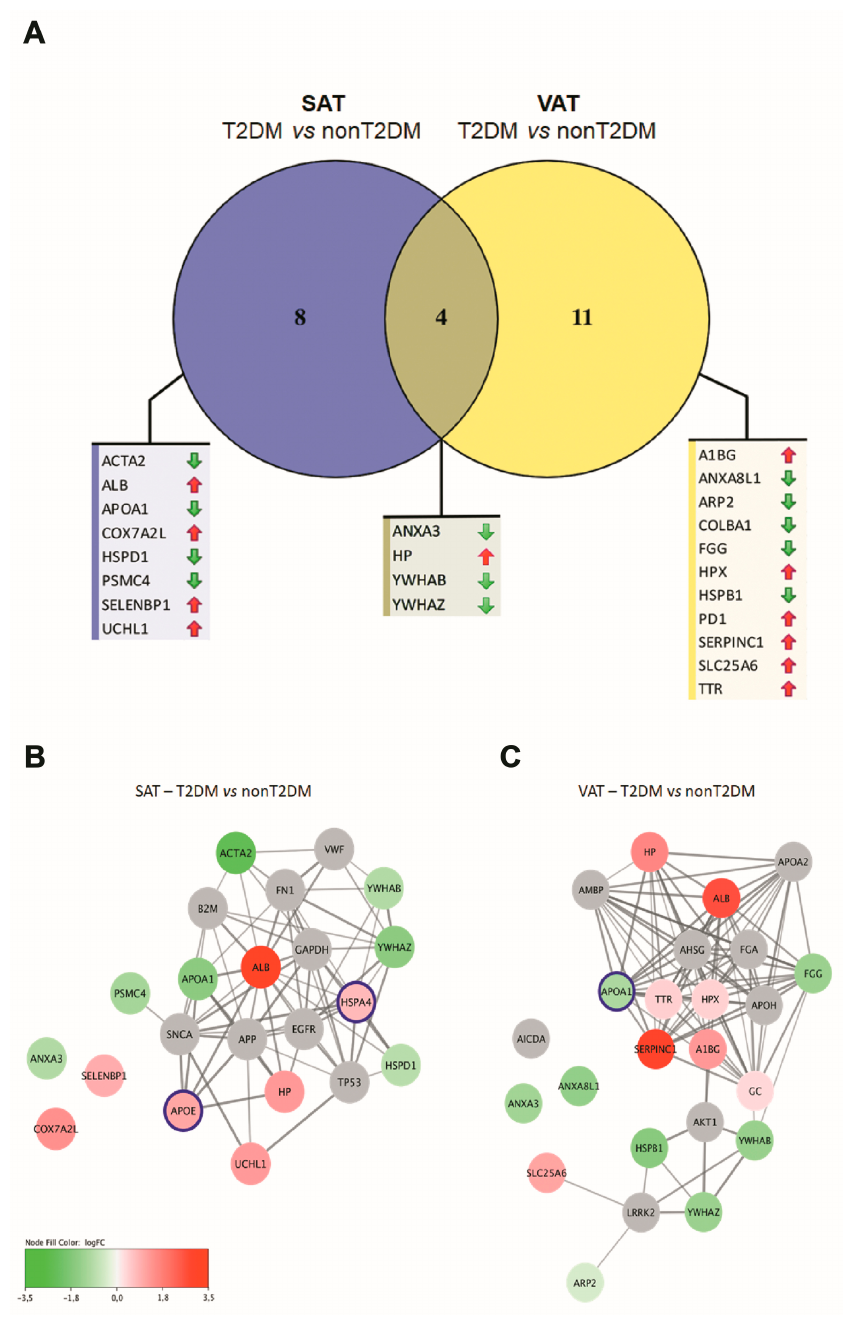
Figure 4. Effect of type 2 diabetes mellitus upon visceral and subcutaneous white adipose tissue proteomes. ( A ) Venn diagram of differentially regulated proteins in type 2 diabetes mellitus indi- viduals (T2DM) compared to non-type 2 diabetes mellitus individuals (nT2DM) for VAT and SAT depots. Only proteins with significant protein expression changes ( p < 0.05) were included, red arrows upregulated, green arrows downregulated. ( B ) Protein–protein interaction network analysis of VAT differentially expressed proteins in T2DM. ( C ) Protein–protein interaction network analysis of SAT differentially expressed proteins in T2DM. Nodes coloring represents log fold-change between T2DM and nT2DM; gray nodes represent predicted protein interactions; nodes highlighted in purple represent predicted proteins that were detected within the proteomic analysis but did not reach significance.